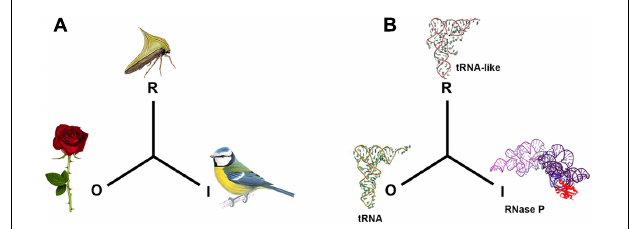
FIGURE 1 | Mimetic relationships. In biosemiotic terms and according to the sign system of Peirce, the mimetic signal corresponds to the representamen (R), the model to the object (O) and the operator to the Interpretant (I) (Kilstrup, 2015). In (A) , the plant’s thorn is the Object (O), the thorn bug is the Representamen (R) and the predatory bird that the prey eludes is the Interpretant (I). In (B) , a molecular example: the tRNA Phe is considered to be the Object (O), the 3 (cid:48) untranslated end of the genome of plant virus TYMV is the representamen (R), while the interpretant (I) is the tRNA precursor processing enzyme RNase